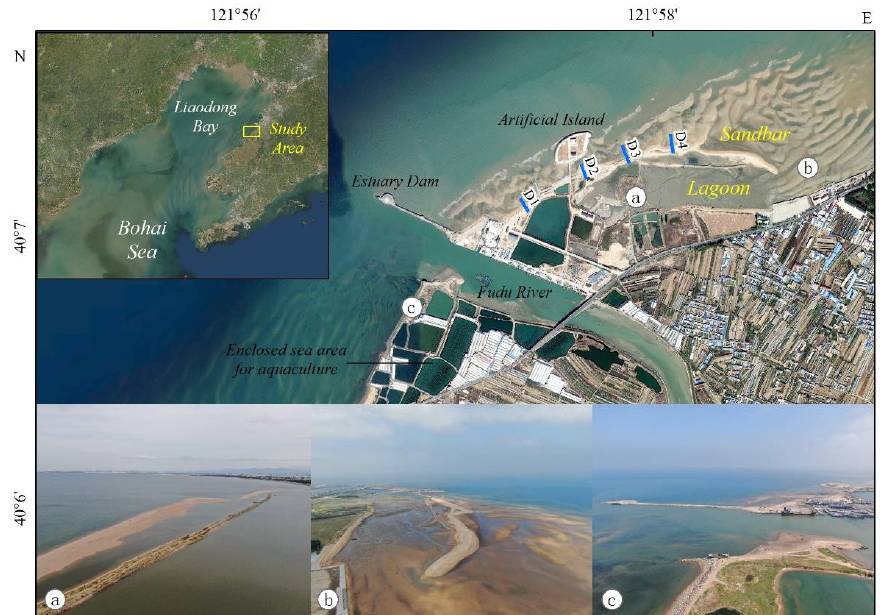
Figure 1. Geographical Location and Overview of the Fudu Estuary Sandbar Lagoon (FESL). Remote sensing images are obtained from ESRI with a spatial resolution of 2.39 m. Photos A, B, and C were taken in June 2021.